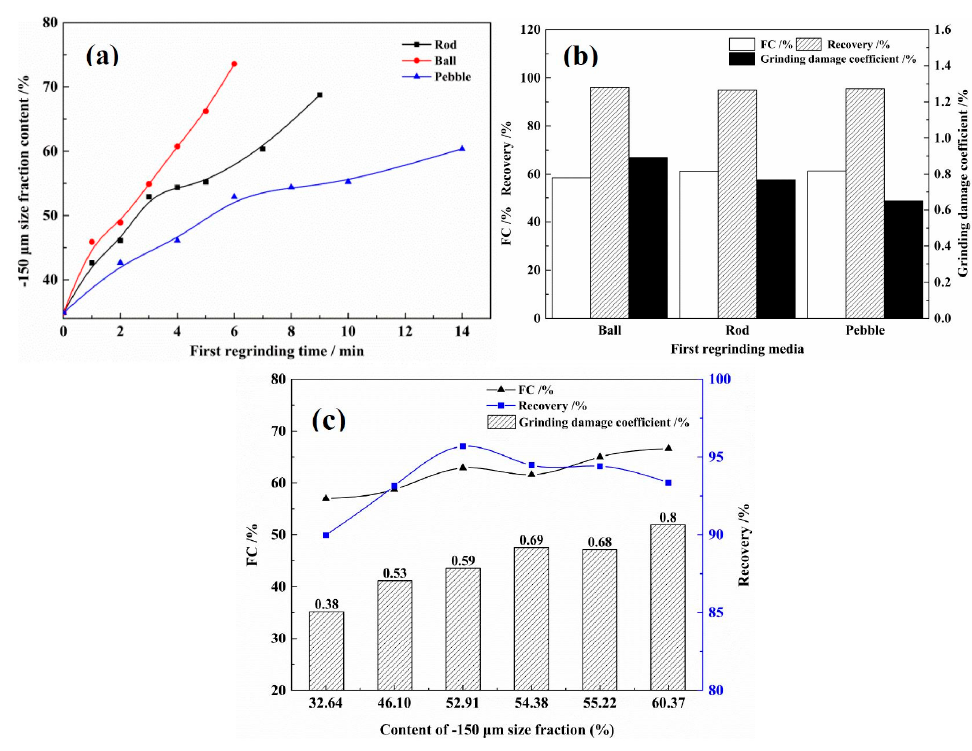
Figure 6. Experimental parameters of first regrinding tests: ( a ) First regrinding curves; ( b ) regrinding media; ( c ) regrinding fineness.